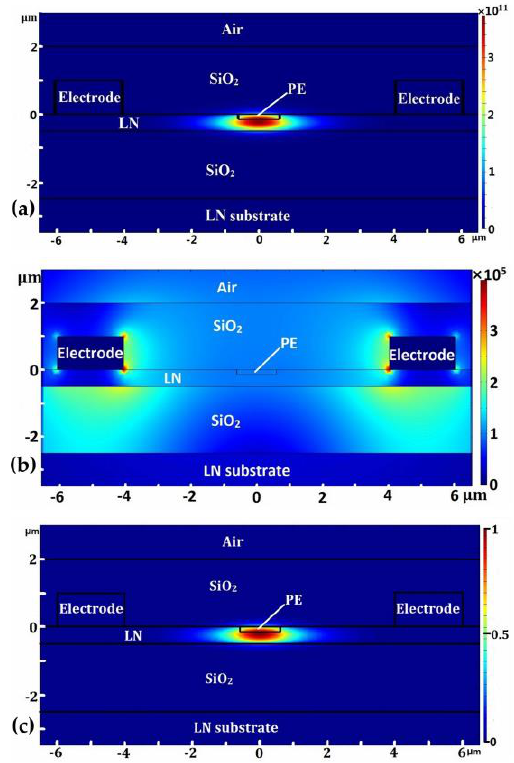
Figure 6. (a) Optical field inside the waveguide. (b) Electrostatic field after a 1 V voltage was applied to the electrodes. (c) Normalized product of the optical and electrical fields.